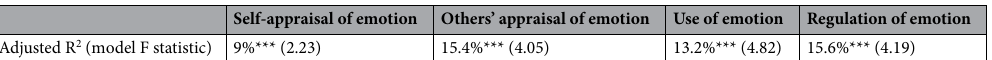
Self-appraisal of emotion Others’ appraisal of emotion Use of emotion Regulation of emotion Adjusted R 2 (model F statistic) 9%*** Table 5. Regression model fit measures. The fit measures in the top row are of OLS stepwise regressions of the whole sample; adjusted R2 measures are given and the F statistic of the models. ***p < 0.01.